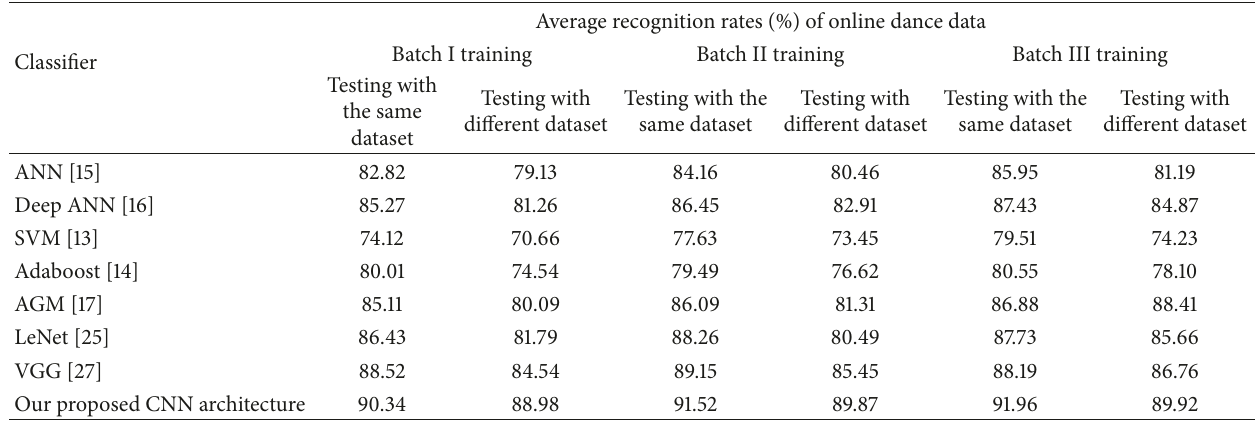
Table 5: Recognition rates of online dance data identification with different